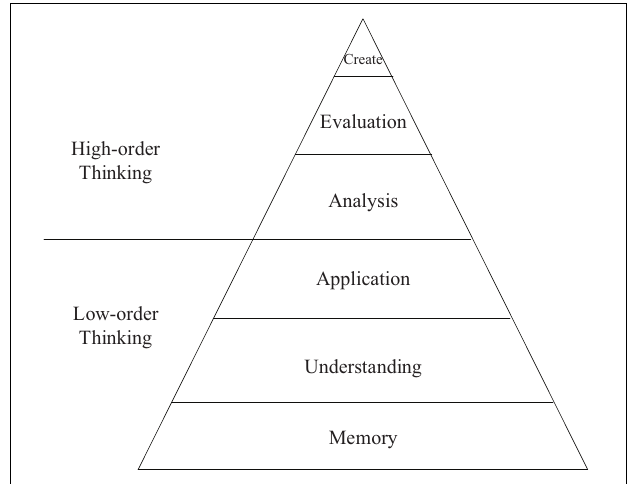
FIGURE 1 | Bloom’s